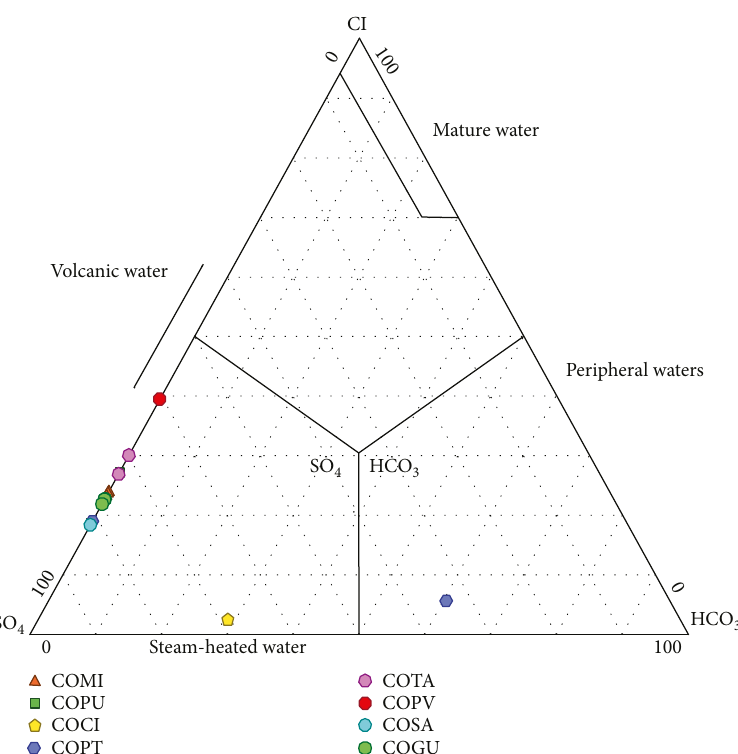
Figure 7: Ternary diagram of anions for the sources in Puracé-La Mina [39].